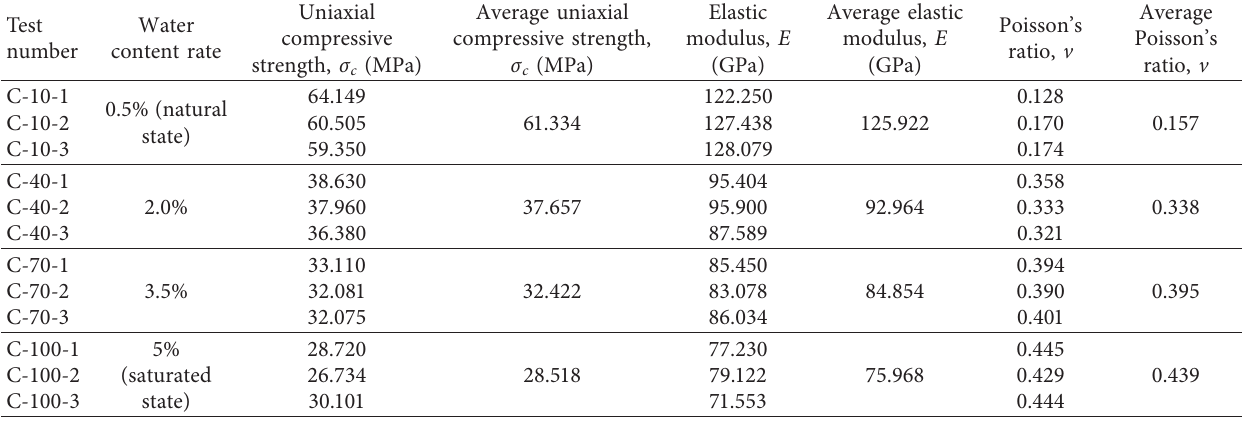
Table 1: The uniaxial compression experiment calculation results.